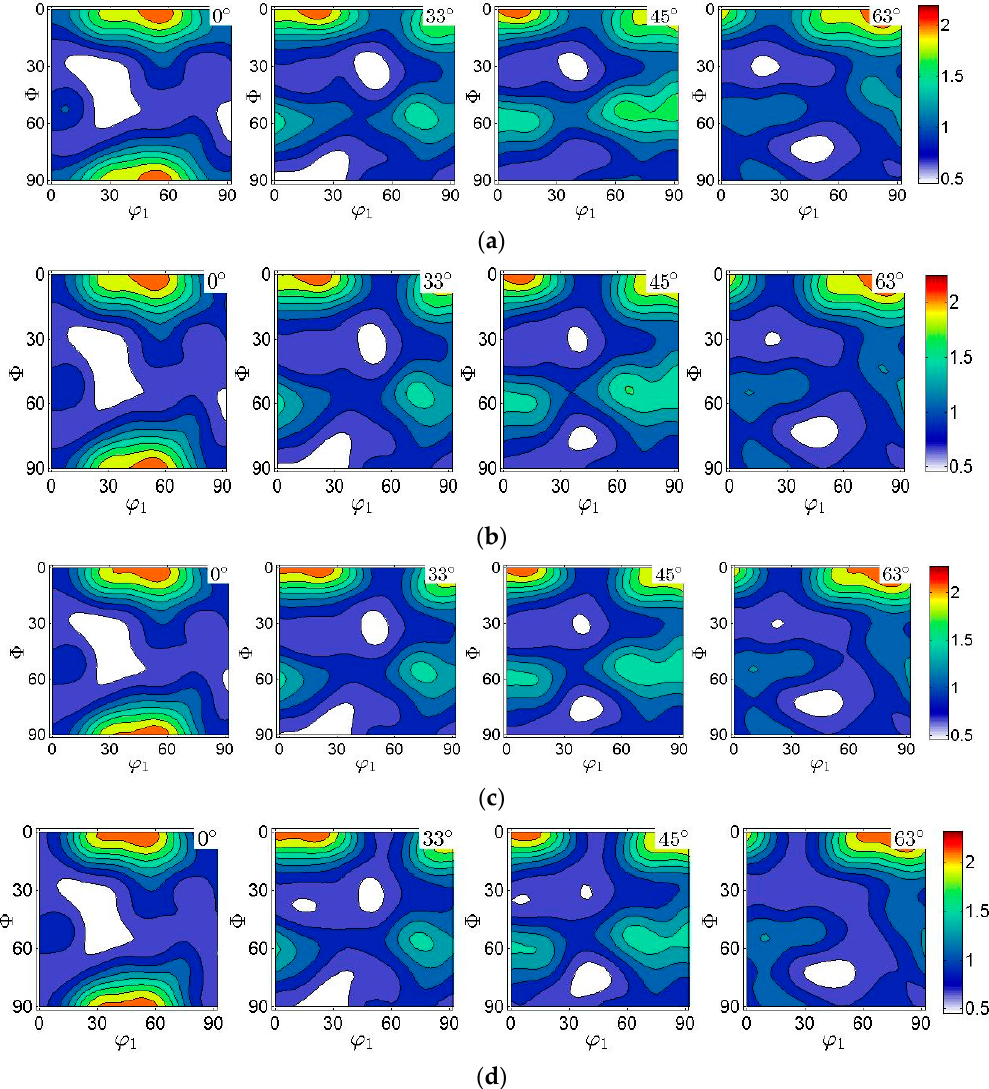
Figure 12. The ODF evolution during stretching in the rolling direction. ( a ) When the strain is 0.050. ( b ) When the strain is 0.107. ( c ) When the strain is 0.125. ( d ) When the strain is 0.161. Table 7. Slip systems and reference